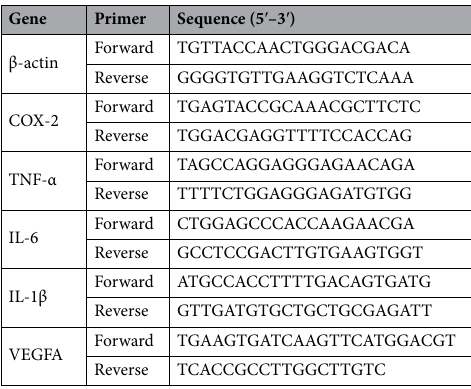
Table 4. Primers used for the quantitative RT-PCR.